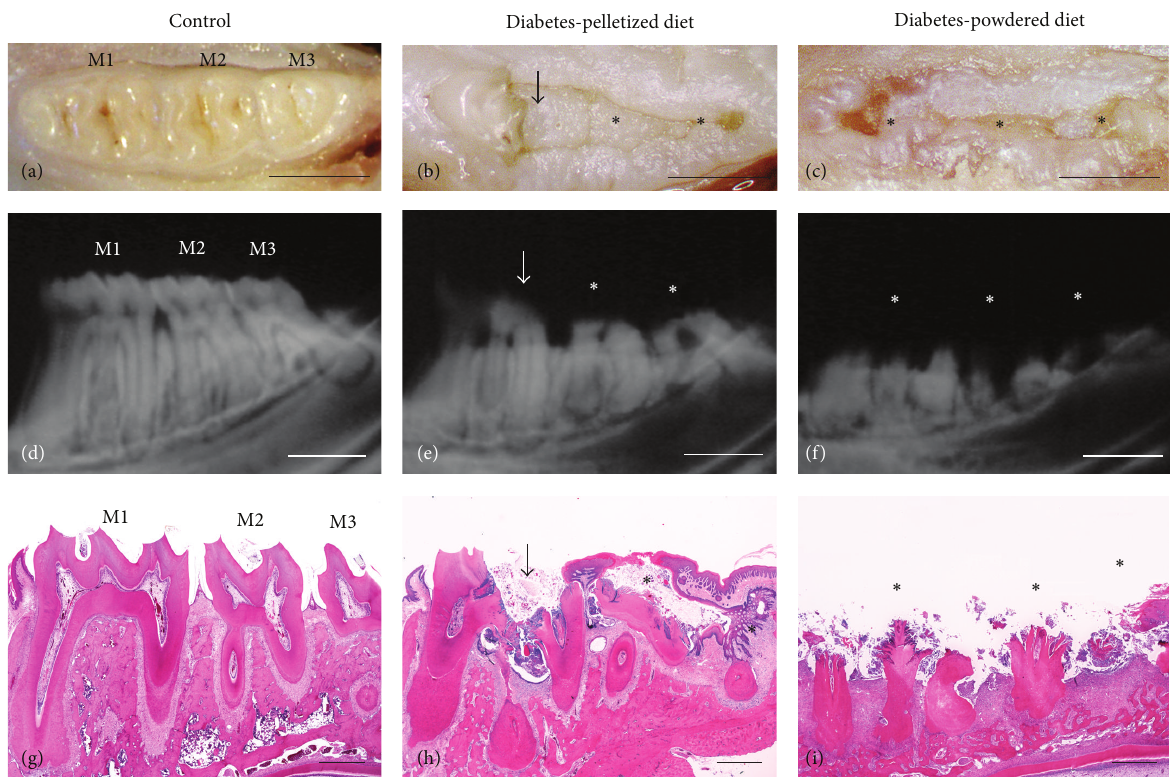
Figure 3: Morphological characteristics of molar caries in the mandibles of female F344 rats. M1: the first molar, M2: the second molar, and M3: the third molar. (a–c) Macroscopic appearance of molar caries. (a) Normal molars. (b) Partial coronal defect (arrow) of M1 and complete coronal defects (asterisks) of M2 and M3. (c) Complete coronal defects (asterisks) of all of the molars (M1–M3). Scale bar = 2mm. (d–f) Soft X-ray images of the molar caries. (d) Normal molars. (e) Corresponding to the macroscopic observation, dental caries with a focal (arrow) or an extensive radiolucent area (asterisks) in the dental crown is observed. The caries were graded as 2 (M1), 4 (M2), and 3 (M3). (f) The dental crowns are completely absent in all of the molars (grade 4, asterisks). Scale bar = 2mm. (g–i) Histopathological features of the carious lesions. (g) Normal molars. (h) Moderate-to-severe carious lesions. Dentin caries spread over a large part of the dental crown. (i) Severe